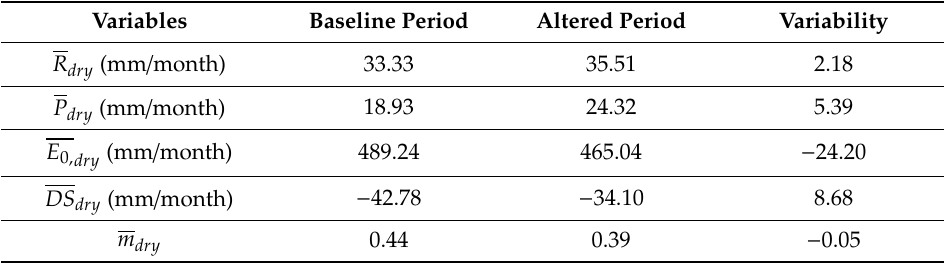
Table 7. Change in mean monthly hydro-climatic variables due to climate change and anthropogenic activities.